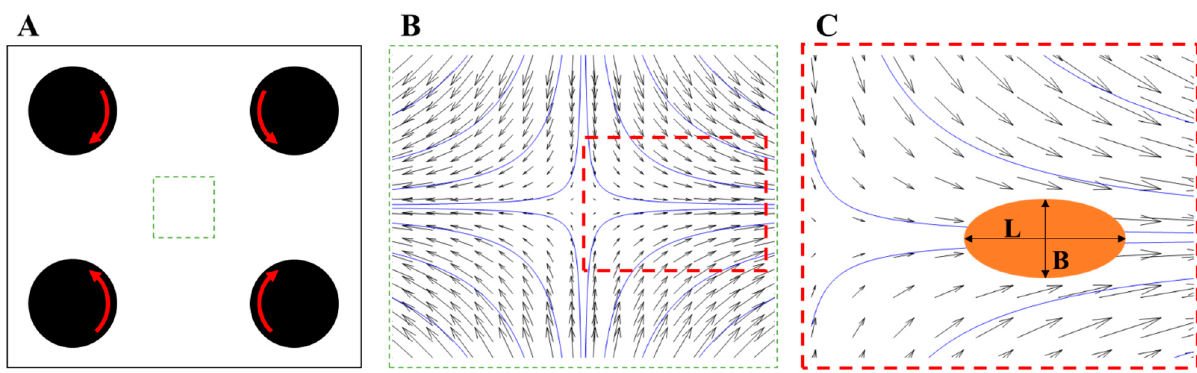
Figure 2. Schematically illustration of laminar breakup in a four-roller mill [33,35]: ( A ) The four-roller mill; ( B ) the laminar velocity profiles (with streamlines); ( C ) schematic illustration of the laminar shear experienced by a drop placed in the flow.